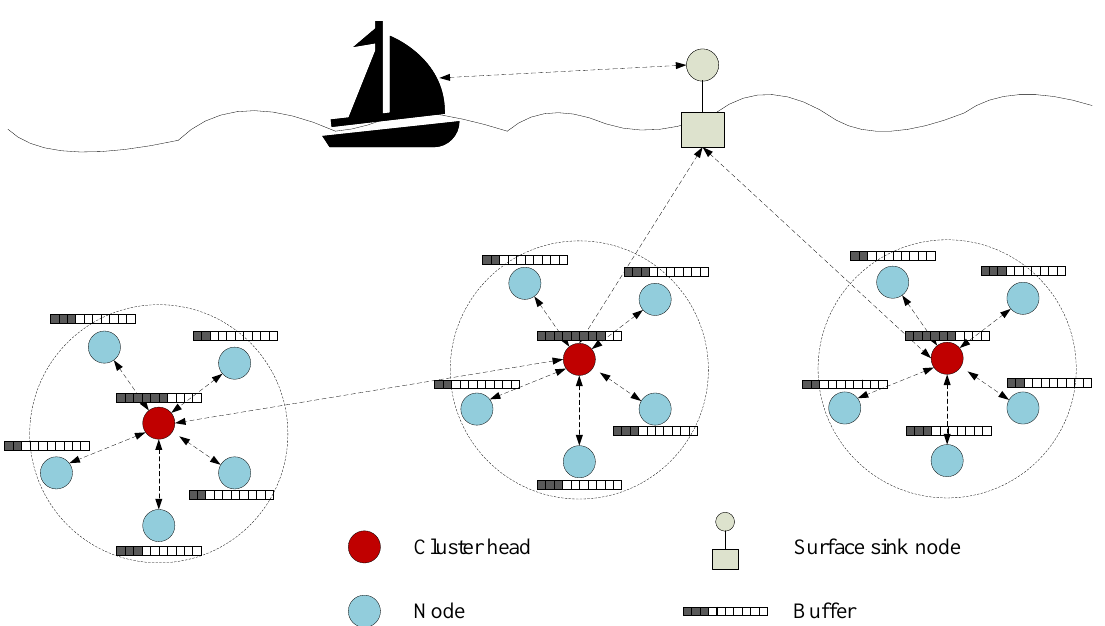
Figure 2. Multi-hop clustered underwater acoustic sensor